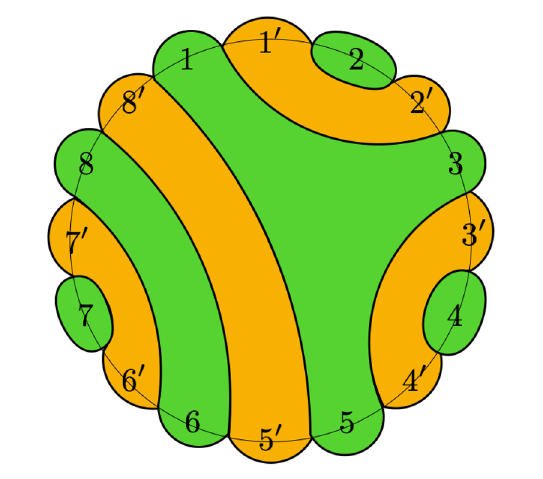
Figure 22 . The group action of a non-crossing permutation g is represented by its orbits (green) acting on the elements i ∈ 1 , 2 , . . . , N , where N = 8 . The action of τg − 1 is represented by its orbits (orange) acting on the same elements denoted i 0 for